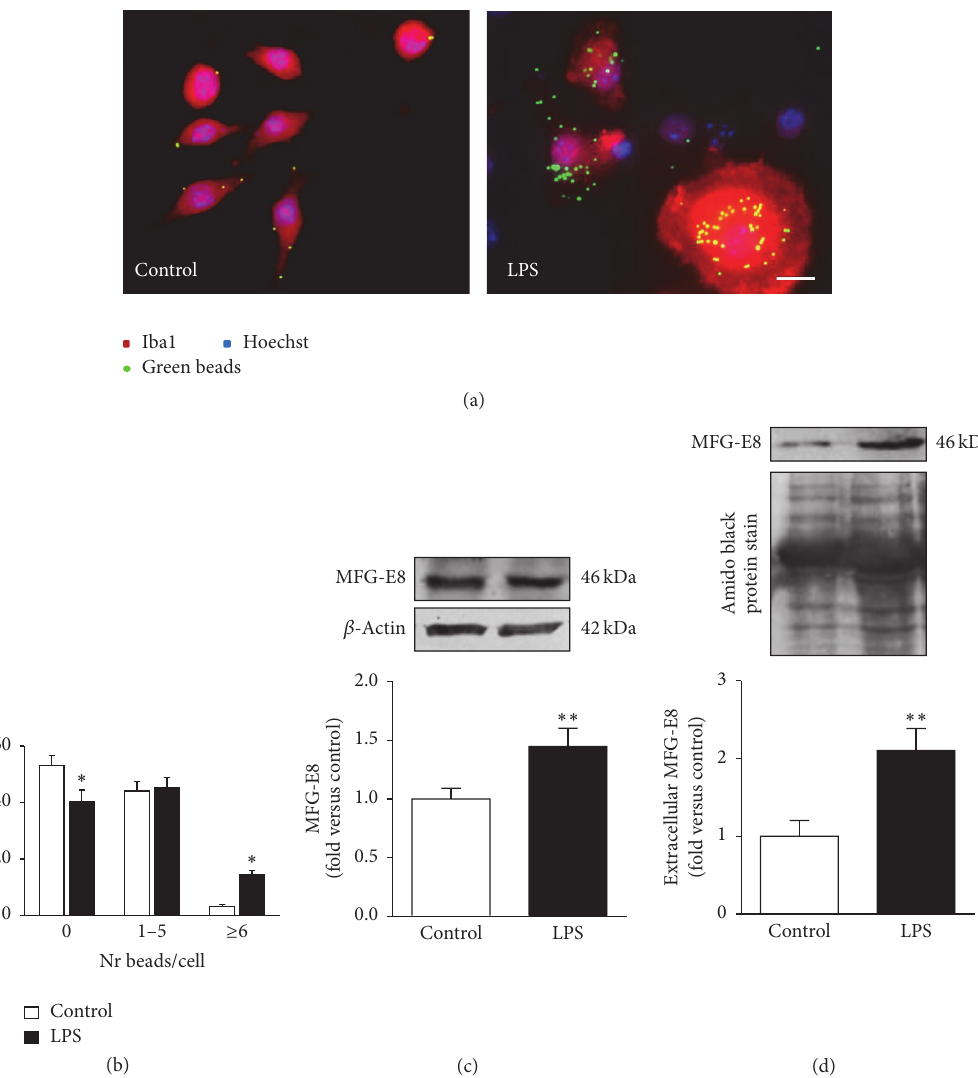
Figure 4: M1 polarized N9 microglia show enhanced phagocytic ability and milk fat globule-EGF factor 8 (MFG-E8) upregulated expression. Representative results of one experiment are shown for the phagocytosis of latex beads (a) and results are expressed as the percentage of cells engulfing specific numbers of ingested beads versus total number of cells (b). MFG-E8 expression and release were assessed by Western blot analysis ((c) and (d), resp.). Results are mean ± s.e.m. from five (b) or six (c, d) independent experiments, performed in duplicate. Comparison of more than two groups (b) was done by one-way ANOVA followed by multiple comparisons Bonferroni post hoc correction. Comparisons between lipopolysaccharide- (LPS-) treated N9 cells and nontreated cells (control) were made via two-tailed Student’s 𝑡 -test (c, d). ∗ 𝑝 < 0.05 and ∗∗ 𝑝 < 0.01 versus nontreated cells (control). Scale bar represents 20 𝜇